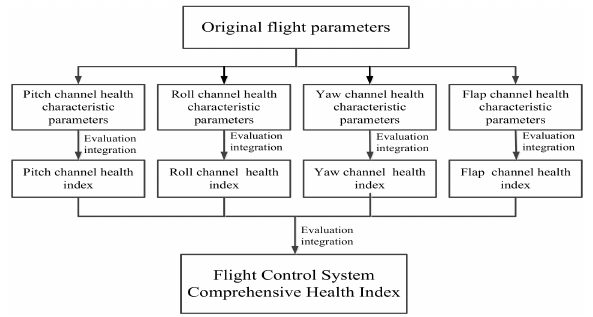
Figure 1. Health assessment model.